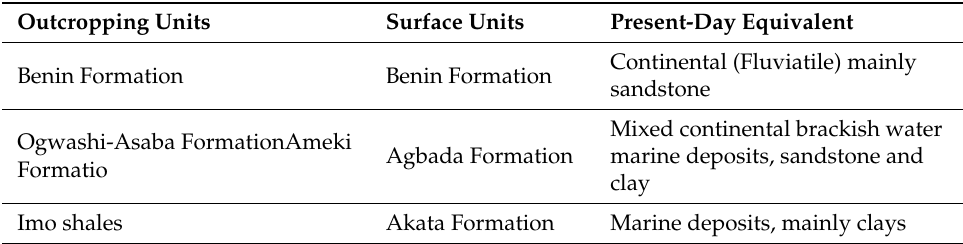
Table 1. Stratigraphic units of the Niger Delta